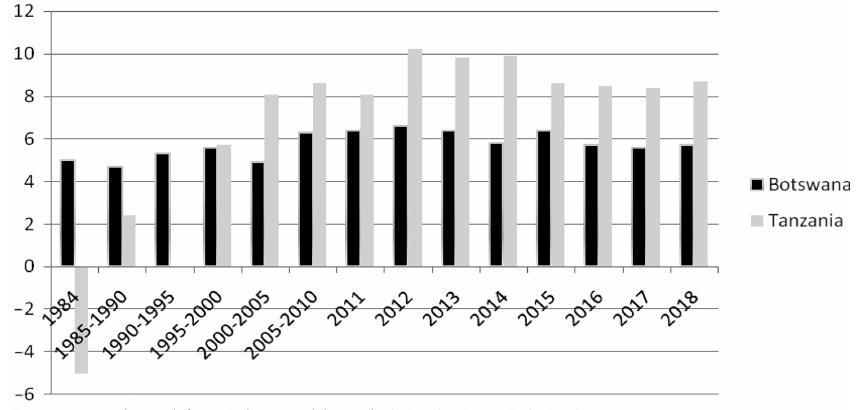
Figure 2. Share of Manufacturing Value Added (MVA) to Total GDP (%) for Botswana and